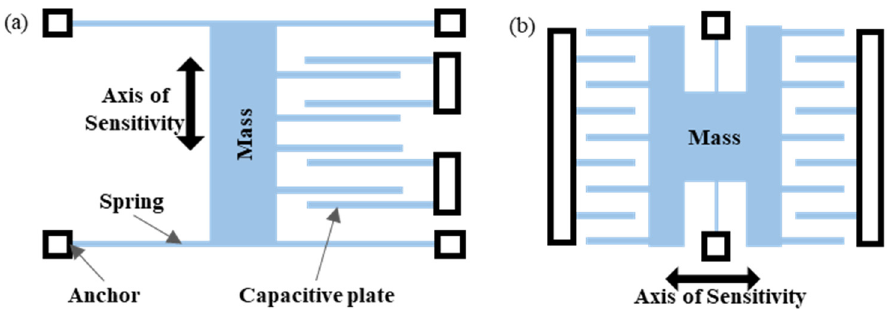
Figure 1. Differential capacitive accelerometer structure: ( a ) variable-gap capacitor accelerometer and ( b ) variable-area capacitive accelerometer.